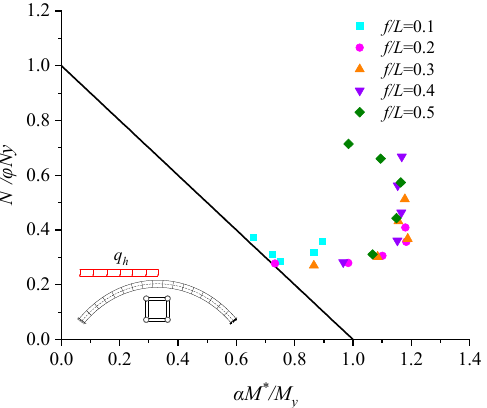
Figure 20. Comparison between the maximum strength pairs and the interaction design curve for the end-fixed Vierendeel truss arches under HSURLs.